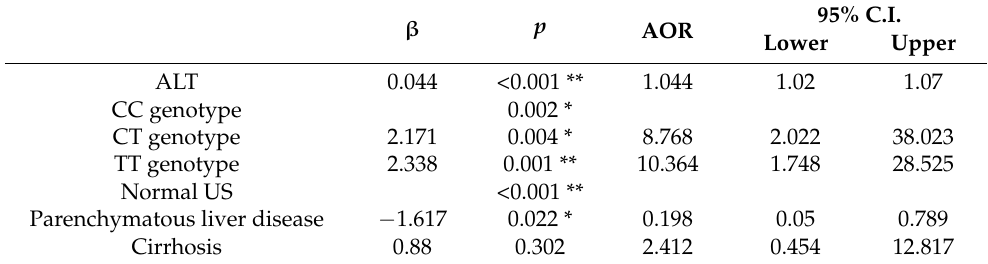
Table 6. Binary logistic regression analysis of the factors associated with